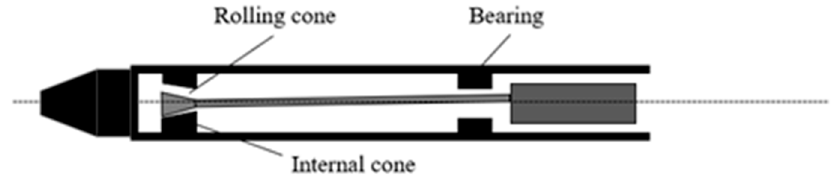
Figure 2. Internal vibration structure diagram of a pendulum vibrator.